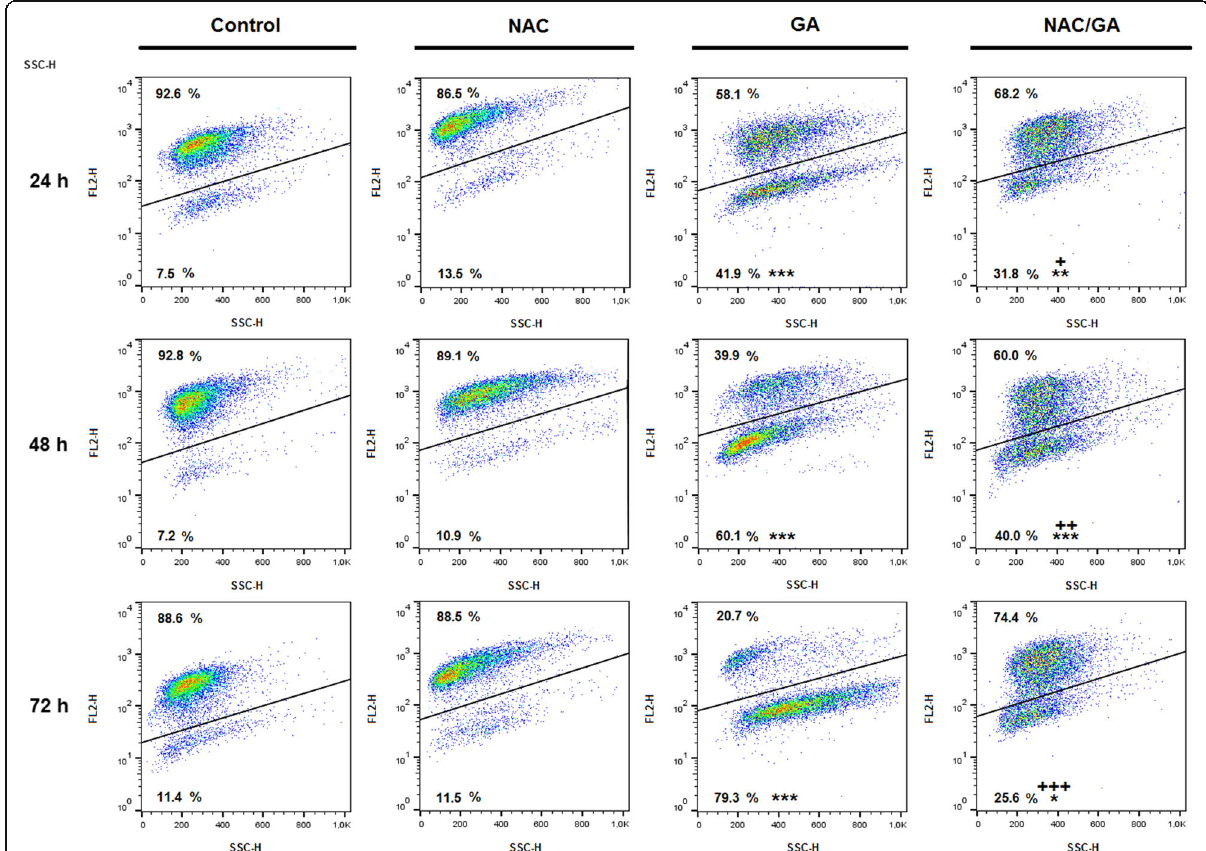
Fig. 4 Representative dot-plot diagram of MMP changes after GA treatment alone or after NAC pre-treatment. Data were obtained from three independent experiments and significant differences were marked as * P < 0.05, ** P < 0.01, *** P < 0.001 versus untreated cells (control); + P < 0.05, ++ P < 0.01, +++ P < 0.001 versus GA